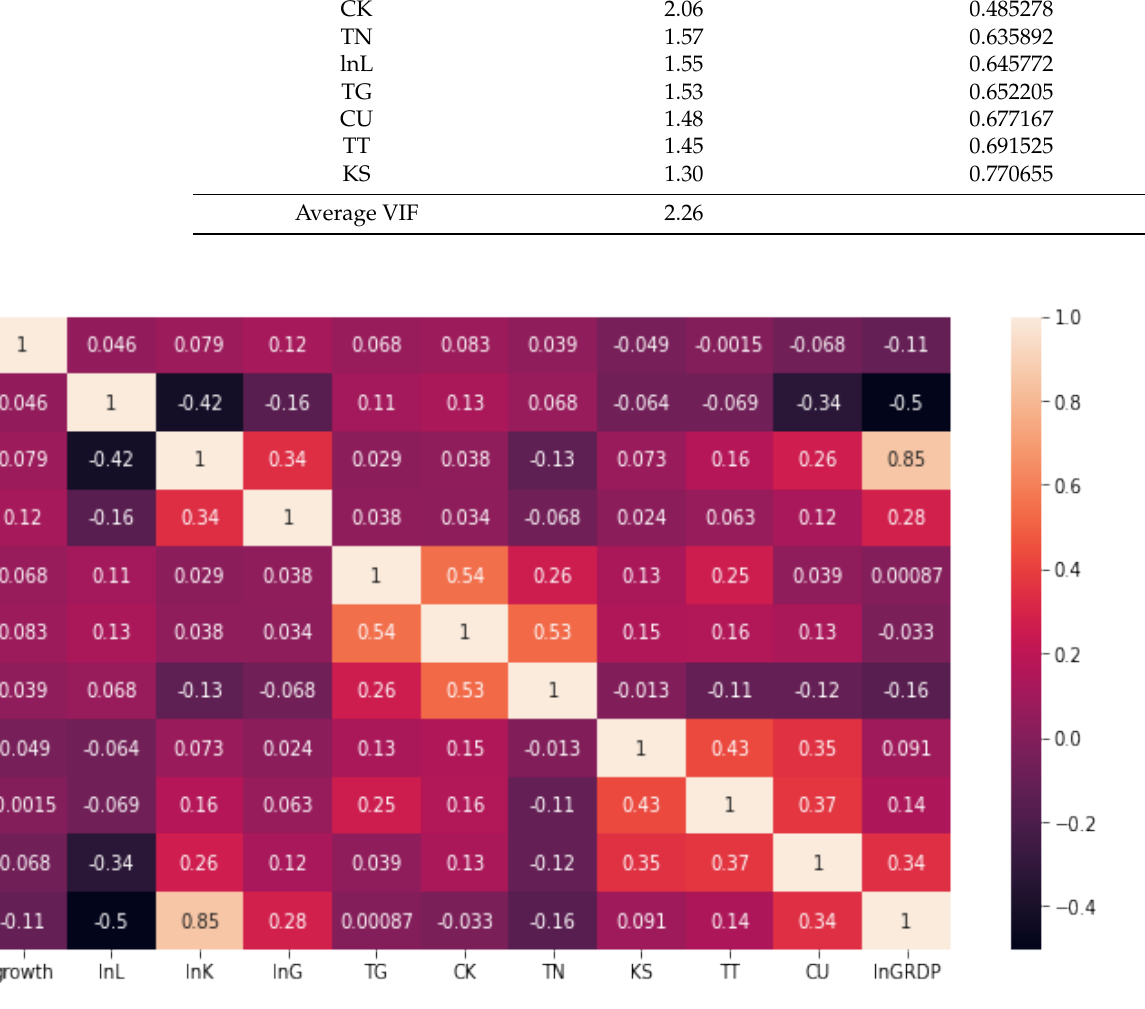
Table 3. Test multicollinearity of independent variables.